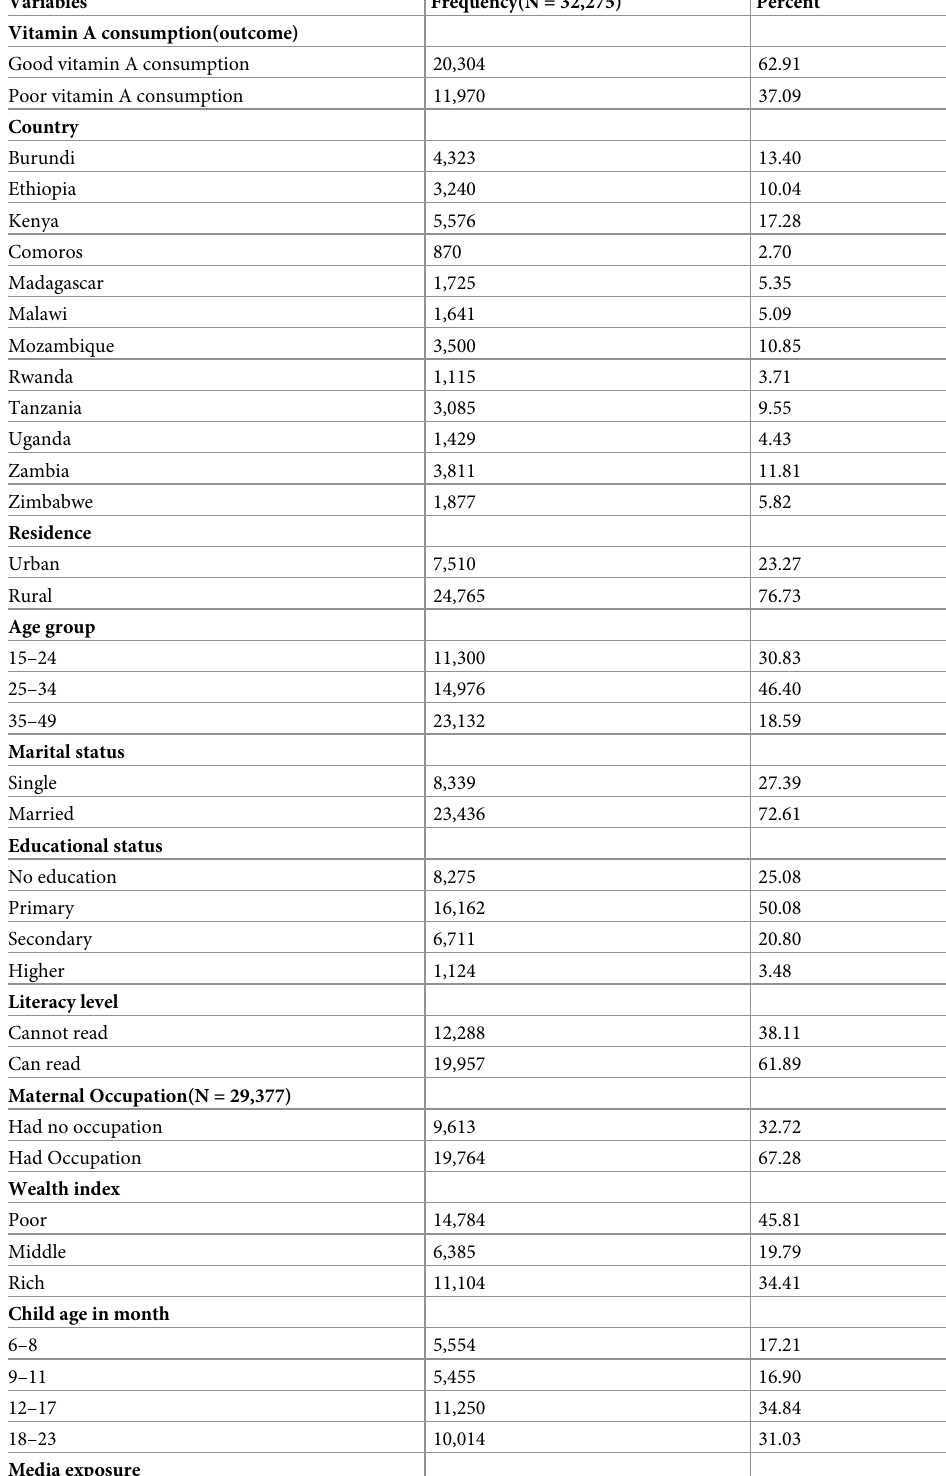
Table 1. Individual and Country level distribution of variables in 12 East Africa Countries from 2008 to